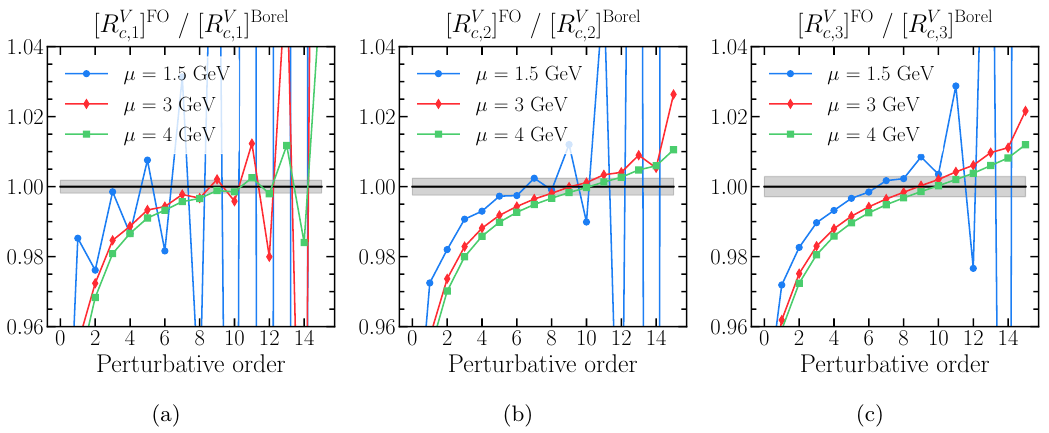
in the large- β limit 0 c,n . The gray band represents the ambiguity c,n